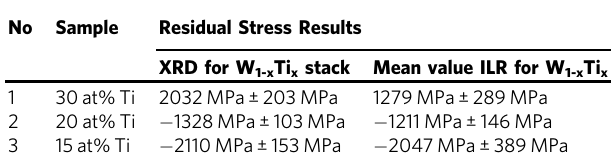
Fig. 3 Residual stress evaluation from de fl ection data utilizing FEM and residual stress prediction. a Numerically determined stress distribution projected on the micro cantilever beam ( − 1.5 to 1.1 GPa). A fi ne mesh with a mesh size of 10 nm, for the ILR-zone is applied in the FEM-modelling. b Numerically determined residual stress pro fi le using the de fl ection evaluated by the GRNN-model for 15 at% (red), 20 at% (green) and 30 at% (blue) Ti, as a function of the layer thickness. A spline fi t is used on the simulated stress pro fi le data. c Schematic shows the work fl ow of the ML-based feed-forward model (MLFF) consisting of two connected multivariable regression (MR) architectures. Regime for compression and tension is highlighted. The connected models are used to provide an estimation about the minority element concentration where the crossing from compressive to tensile stress occurs. The input data for the fi rst MR model is the Ti-concentration. Here, for the training, grain parameters are used. The grain parameters for the different Ti at% (x at% Ti, where x ∈ [0, 30]), which display the output of the fi rst model, are used as an input for the second MR model. Experimentally evaluated residual stress data is used to train the second model. d Predicted, residual stresses between 0 and 30 at% Ti. We compare the prediction of the residual stresses by using the evaluated ILR-values along the thickness (red) for the training of the second MR-model. In addition, for comparison various literature 3,32,43 values for different at%Ti and the measured XRD values (blue) are illustrated. The different colours used for the literature values display measurements for different fi lm thicknesses. The feed-forward model architecture predicts a crossing point, at about 26 at% Ti. Table 2 Comparison of residual stresses using the ILR and XRD